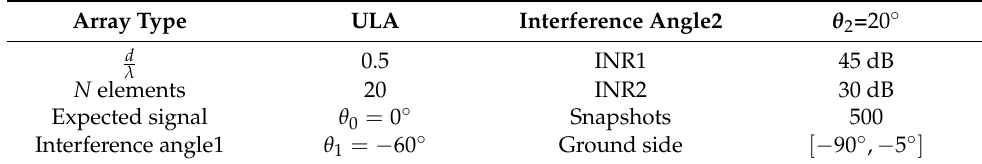
Table 1. Experiment